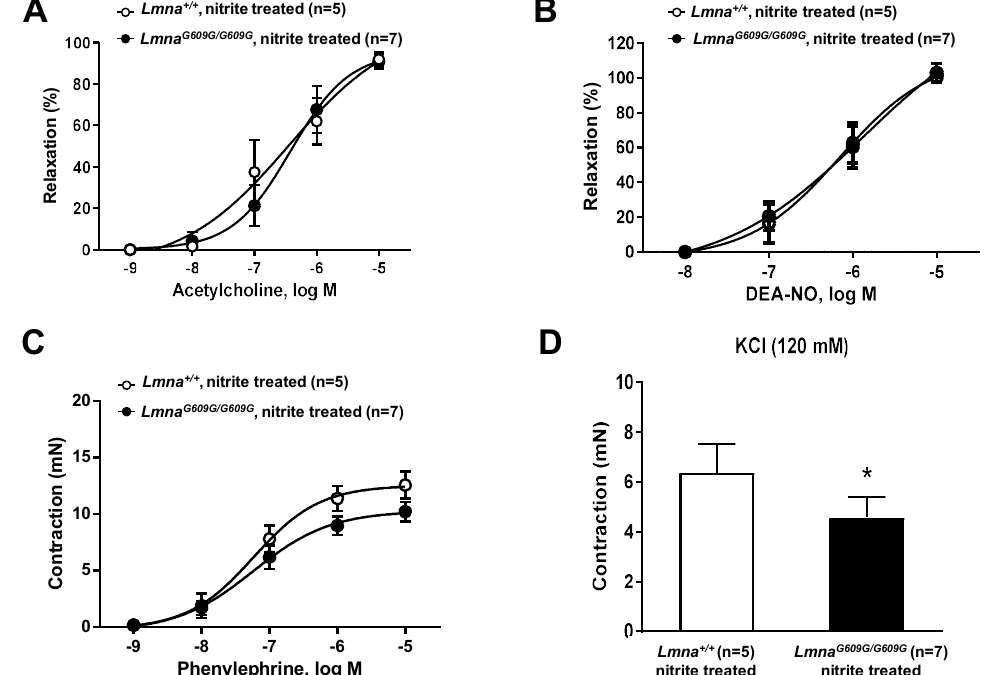
Figure 5. Sodium nitrite treatment improves vascular tone regulation in progeroid mice. Wire myography in thoracic aorta rings from 14-week-old Lmna G609G/G609G and wild-type mice ( Lmna +/+ ) treated with sodium nitrite in drinking water for 6 weeks. ( A ) Endothelium-dependent vasodilation induced by acetylcholine. ( B ) Endothelium-independent vasodilation induced by diethylamine NONOate (DEA-NO). ( C ) Contraction induced by phenylephrine. ( D ) Contraction induced by KCl. Statistical differences were analyzed by two-way ANOVA with Bonferroni’s post-hoc test for acetylcholine, DEA-NO and phenylephrine data, and by two-tailed t -test for KCl data. * p < 0.05.